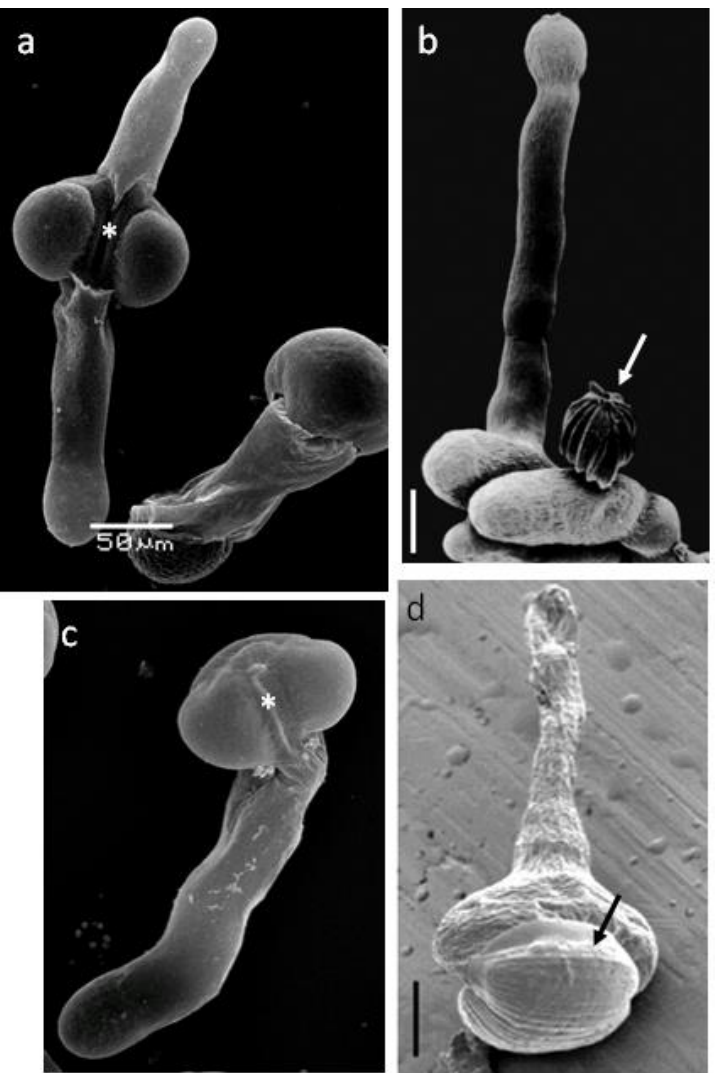
Figure 3. SEM of in vitro pollen germination in three gymnosperm species: Picea pungens Engelm. ( a , c ), Ephedra americana Humb. & Bonpl. ( b ), and Welwitschia mirabilis Hook. f. ( d ): unipolar ( c ) and bipolar pollen germination in Picea ( a ) with exine covering the pollen grain, aperture furrow marked by asterics; pollen tube in Ephedra with the exine shed (marked by an arrow) ( b ); growing pollen tube with the grain partly covered by the exine (marked by an arrow) ( d ). Scale bar: ( a )—50 µm (the same magnification in ( c )), ( b )—20 µm, ( d )—15 µm. Pictures are from the following articles: ( a , c ) [31], ( b ) [32], ( d ) [35].